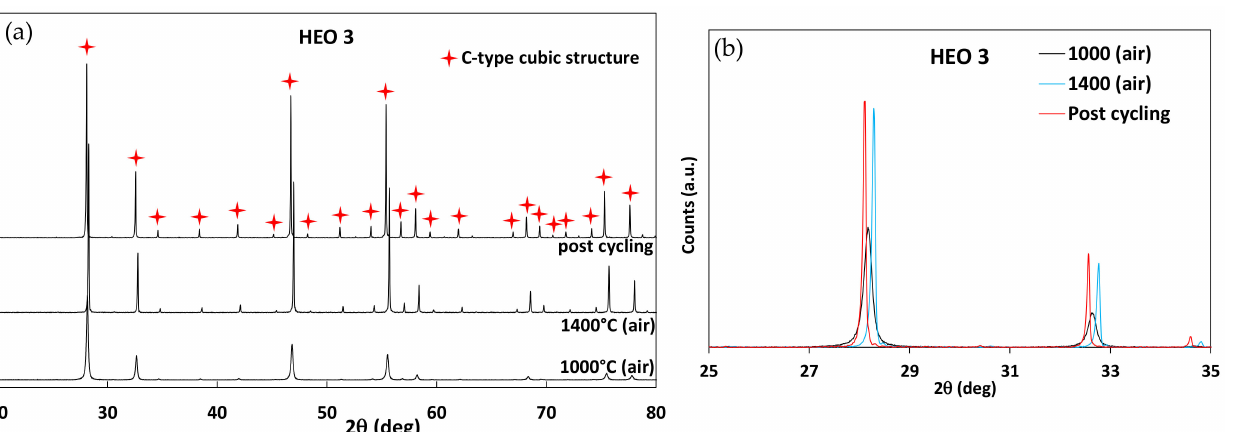
The HEO 3 formula is (Ce 0.2 La 0.2 Pr 0.2 Sm 0.2 Y 0.2 ) 2 O 3 , and this compound has the speci-